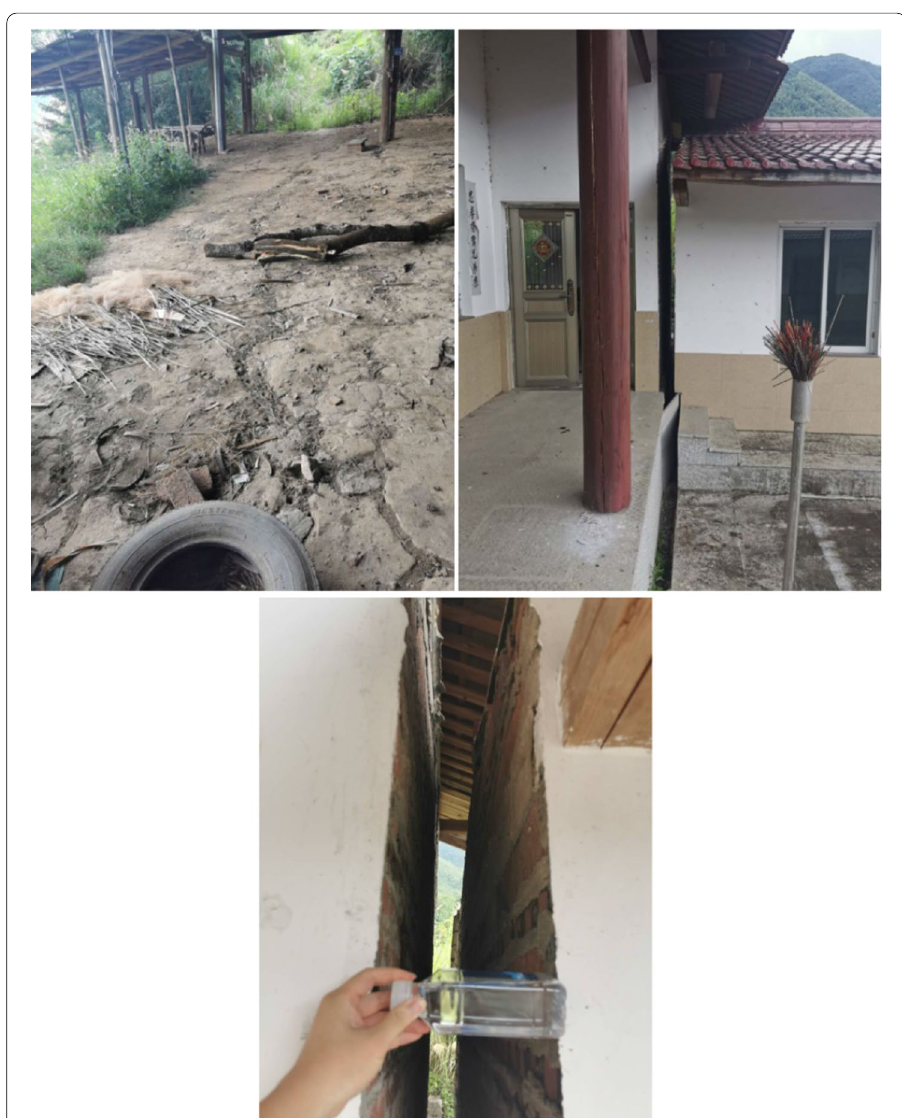
Fig. 4 Tensioned ground cracks and house structure cracking at the back edge of the landslide in Lianyun